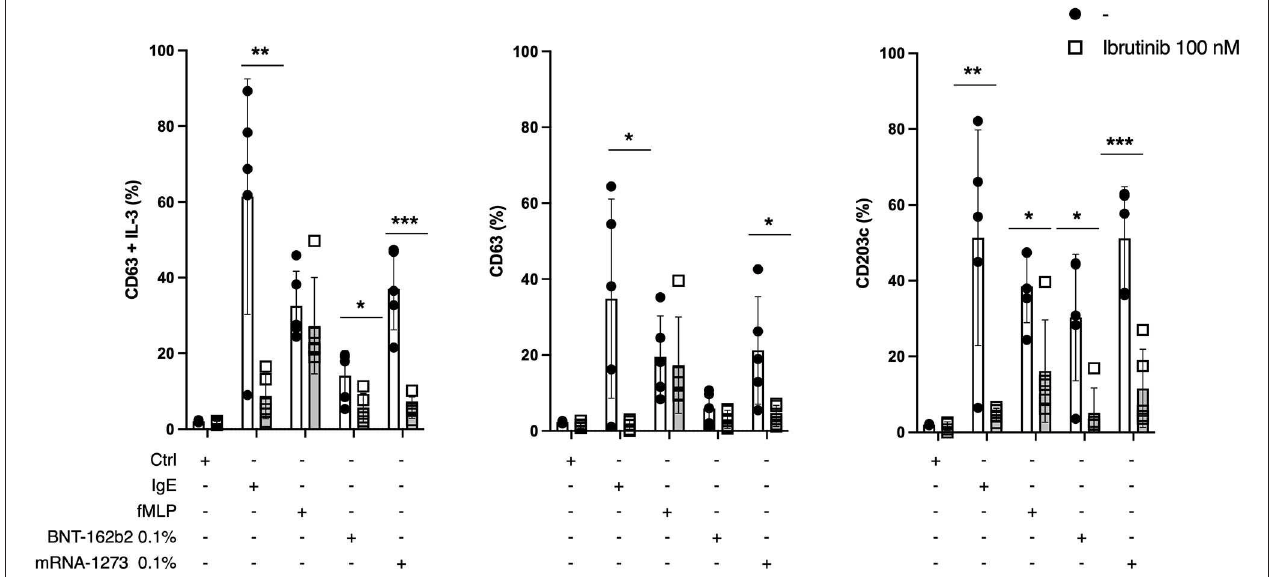
FIGURE 4 | Ibrutinib and basophil activation tests (BAT). Percentage of CD63 ( ± IL3) and CD203c expression after gating on CCR3 + basophils in five individuals which were sensitized to the COVID-19 mRNA vaccines. A total of 100nM of Ibrutinib was added to the control condition (medium-only), basophils were activated with anti-IgE monoclonal antibodies, or fMLP, or 0.1% of the BNT162b2 mRNA or mRNA-1273 vaccines. Multiple unpaired T -test was performed. Mean and SD are shown. * p < 0.05, ** p < 0.01, *** p <